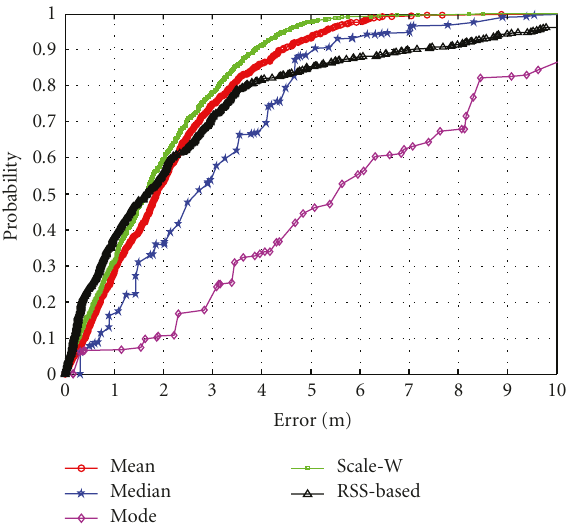
Figure 4: CDFs of distance errors performed with four di ff erent location estimators and an RSS-based